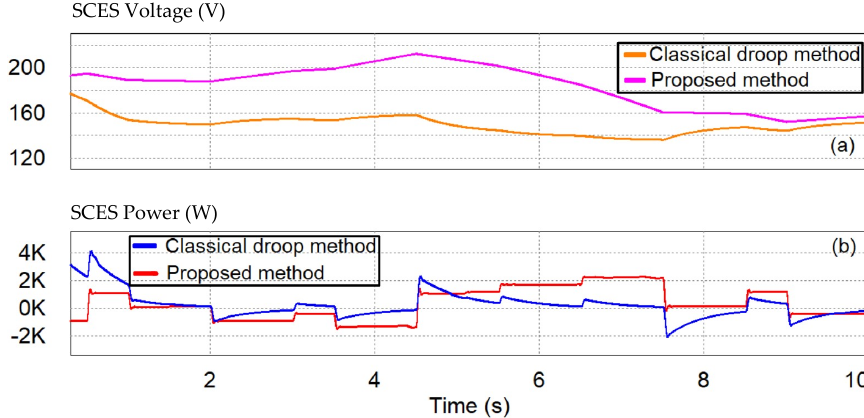
Figure 22. ( a ) The DC bus voltage and the corresponding limits in the proposed method; ( b ) the DC bus voltage in both methods.